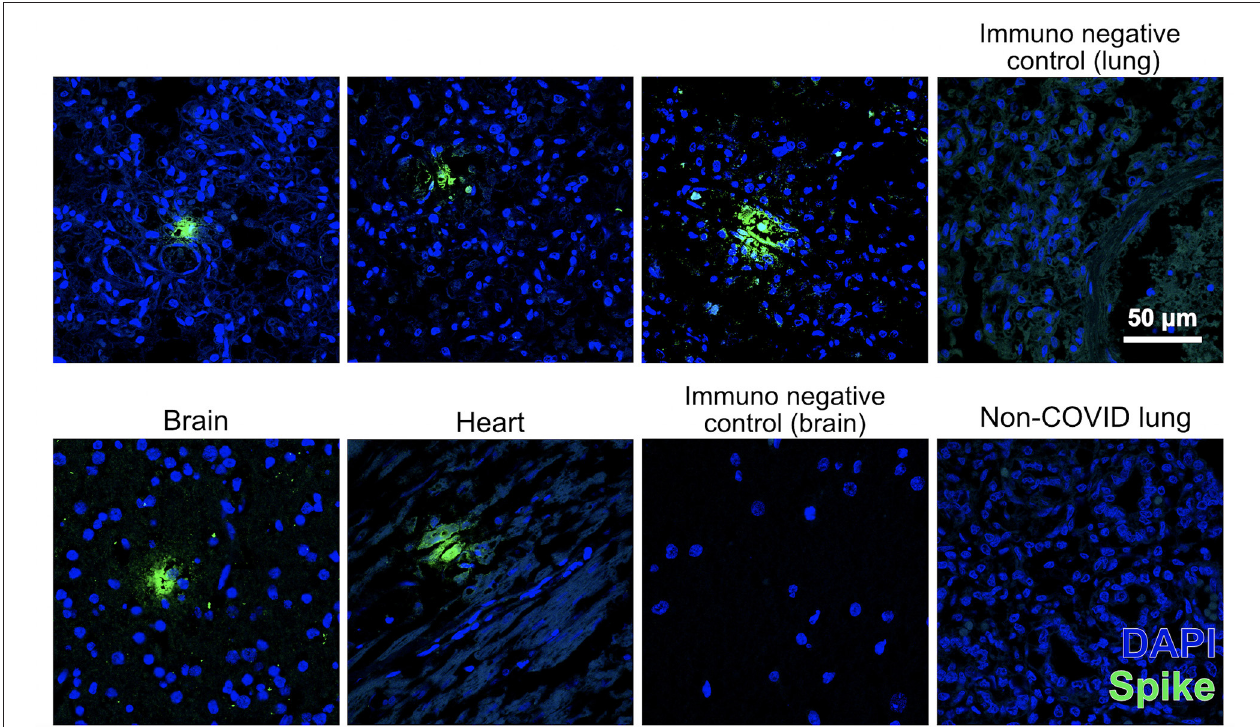
FIGURE 2 | Fetal tissues immunostained for SARS-CoV-2 spike protein (SP) (green) counterstained with nuclear marker DAPI (blue). Images were acquired with a confocal microscope Leica TCS SP8 using a × 63 objective lens. Scale bar for all pictures is 50 µ m. Top pictures: pulmonary immunodetection of SP (the three on the left) and negative control of immunofluorescence without primary antibody (right) in the present case. Lower images: immunodetection of SP in the brain and heart of this case (the two on the left), negative control immunofluorescence without primary antibody in a section of the brain, and lack of immunodetection of SP in a non-COVID fetal lung